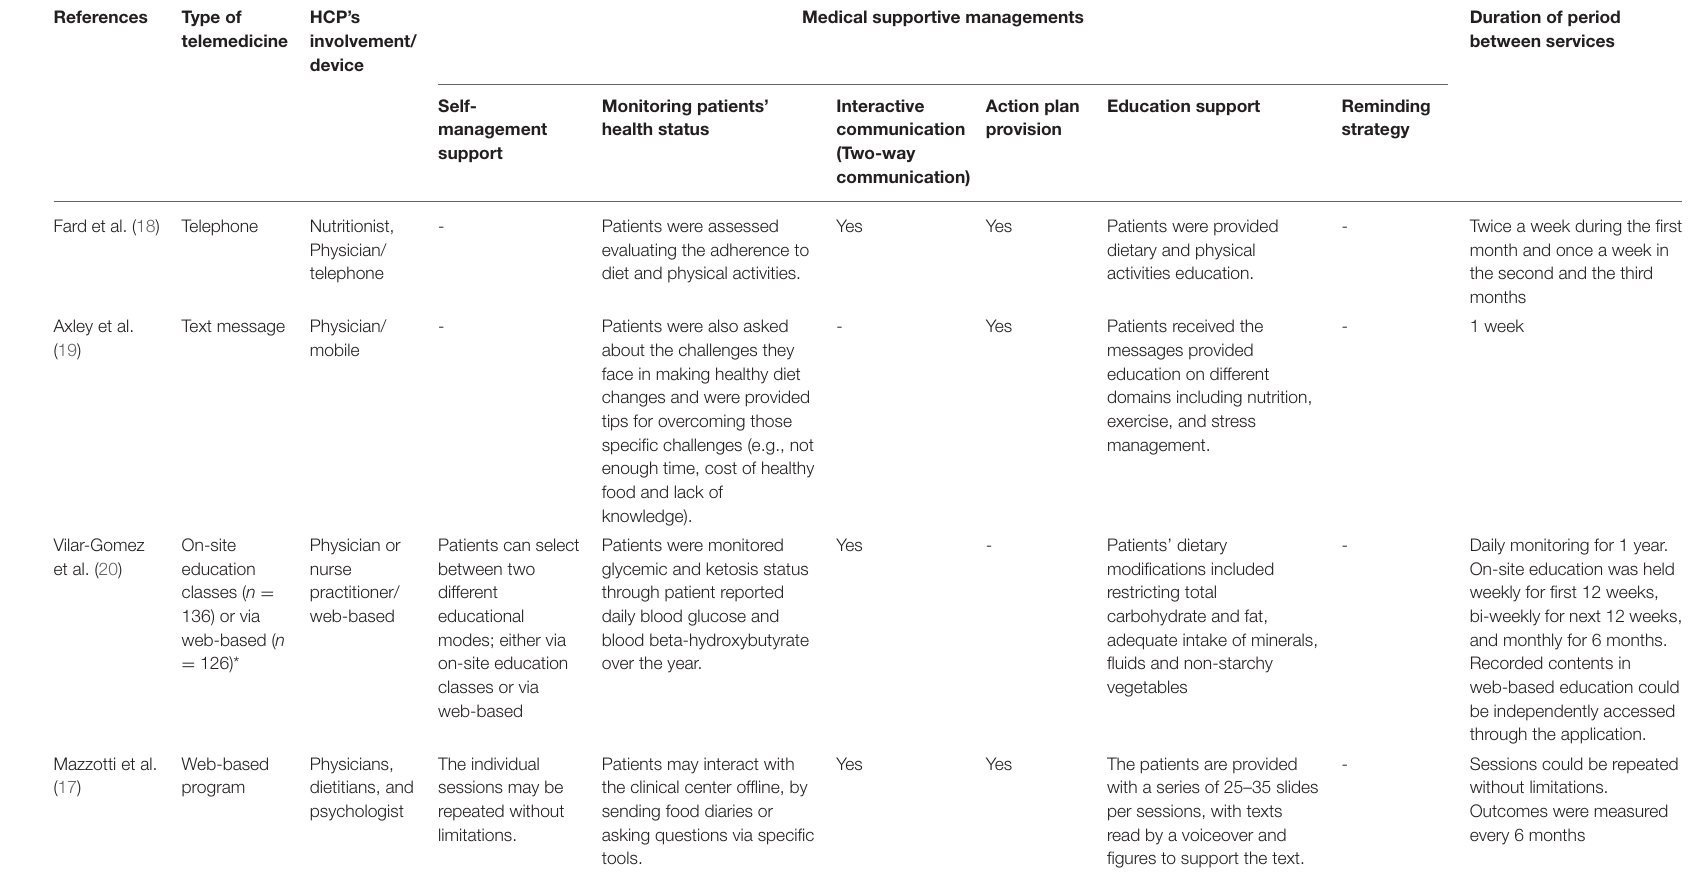
TABLE 2 | Features of telemedicine and the supportive management protocols of the included